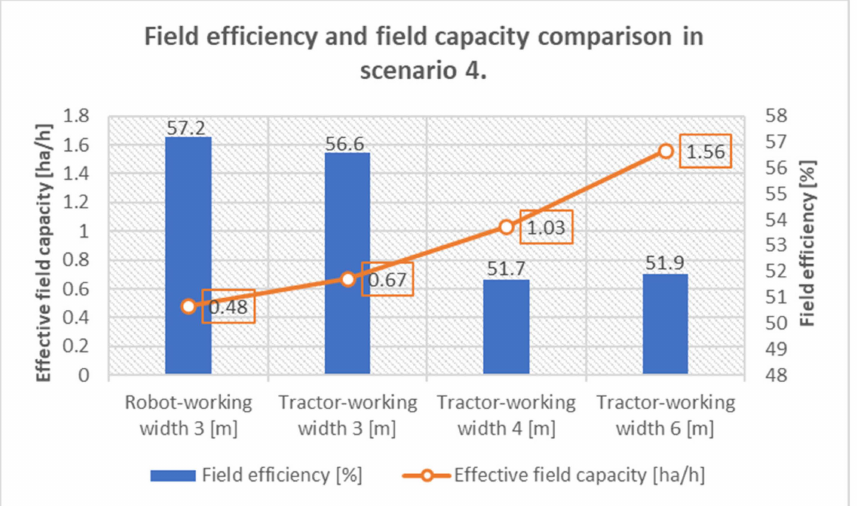
Figure 22. The comparison of field efficiency and field capacity between the robot and tractor in scenario